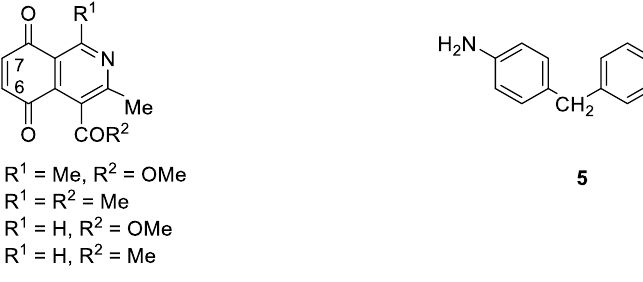
Figure 2. Starting compounds for the target